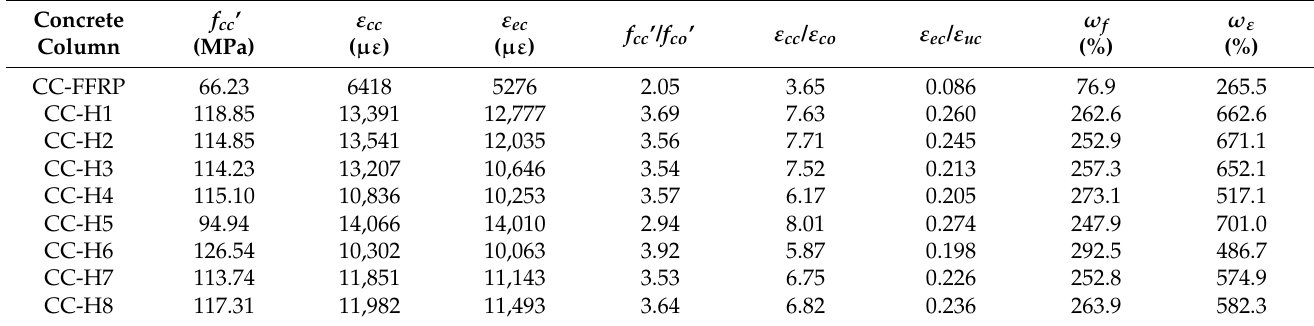
Table 7. Comparison of test results of concrete cylinders under different